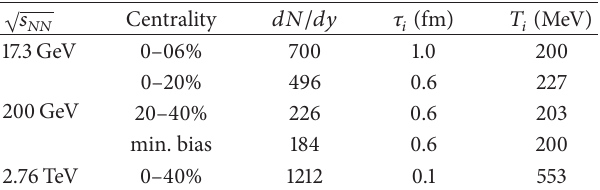
Table1:Thevaluesofvariousparameters—thermalizationtime( 𝜏 𝑖 ), initial temperature ( 𝑇 𝑖 ), and hadronic multiplicity 𝑑𝑁/𝑑𝑦 (the value of 𝑑𝑁/𝑑𝑦 for various beam energies and centralities is calculated from (26))—used in the present calculations.